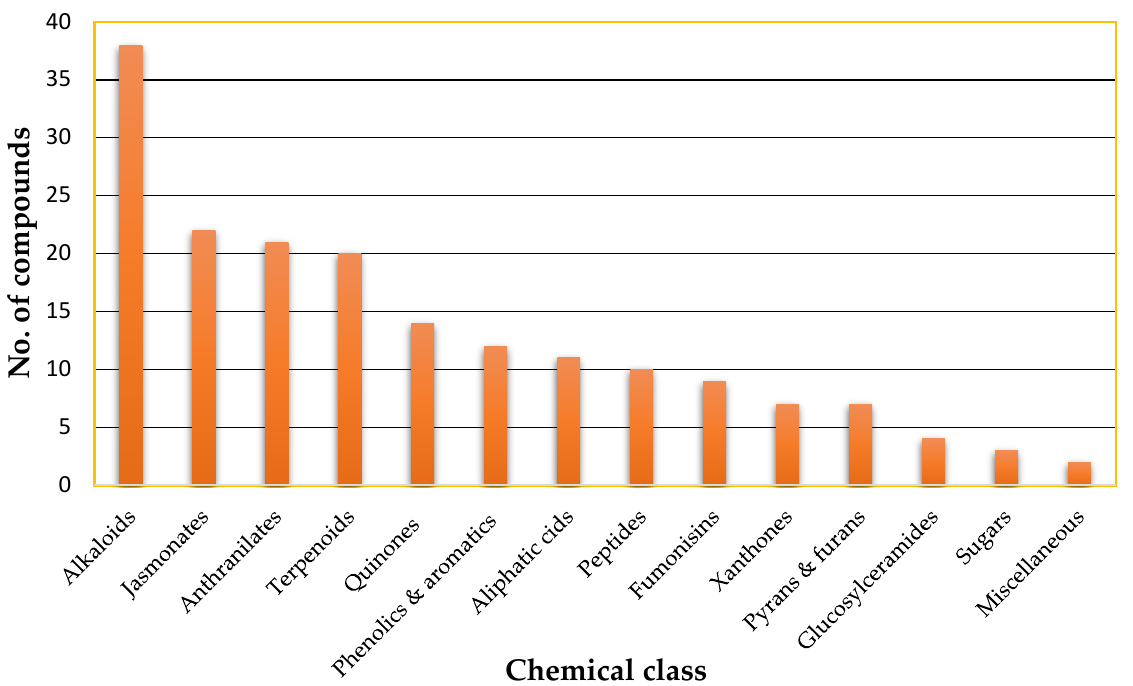
Figure 19. Different classes of metabolites reported from F. oxysporum .